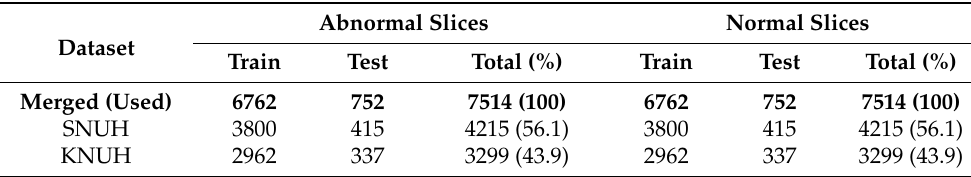
Table 1. The final dataset composed after processing of Abd-CT-DB.